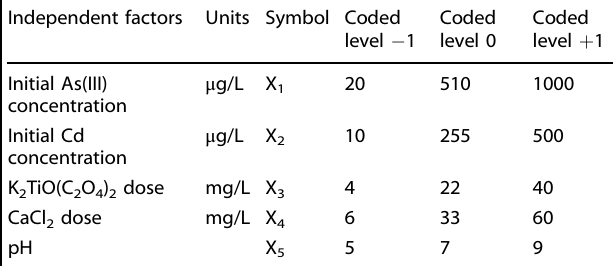
Table 2. Factors and levels for Box-Behnken experimental